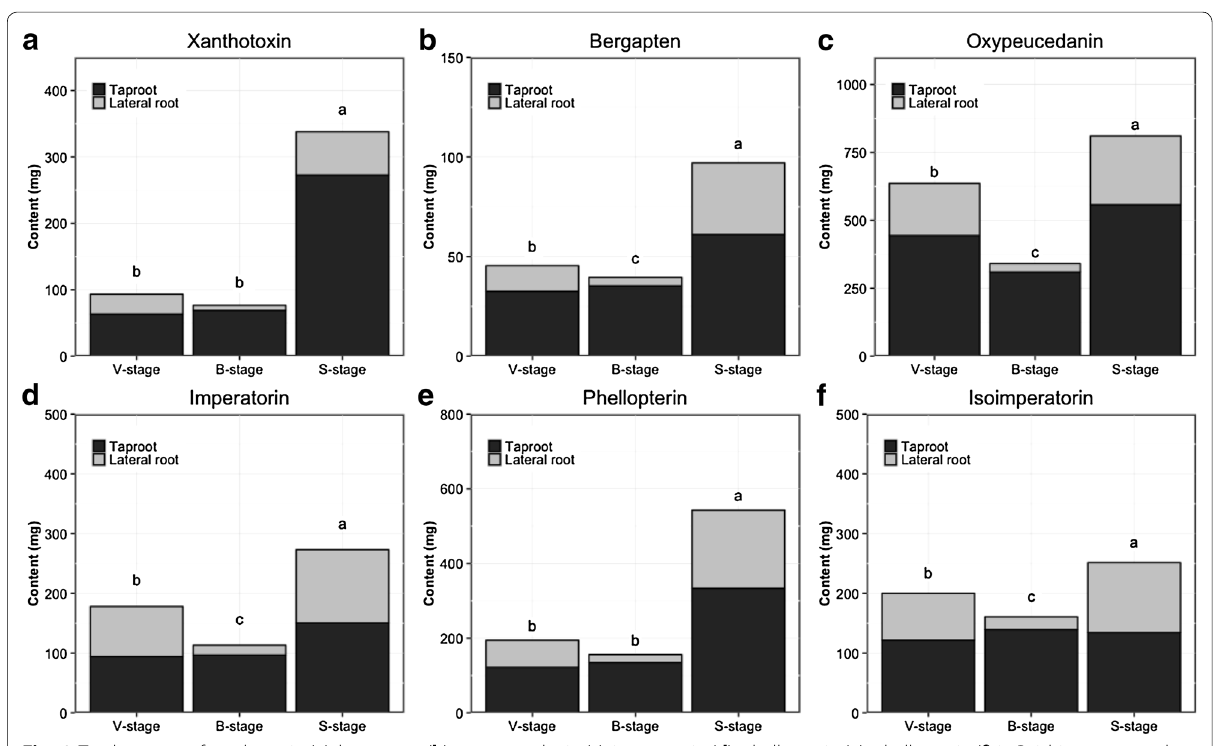
Fig. 6 Total content of xanthotoxin ( a ), bergapten ( b ), oxypeucedanin ( c ), imperatorin ( d ), phellopterin ( e ), phellopterin ( f ) in Baizhi taproots and lateral root harvest at three stages. Data are mean of the DW shown at Table 1 multiplied the content of each furanocoumarin at each stage’s tap‑ root (black bars) and lateral root (gray bars). Different letters indicate statistical significance (p < 0.05) by LSD